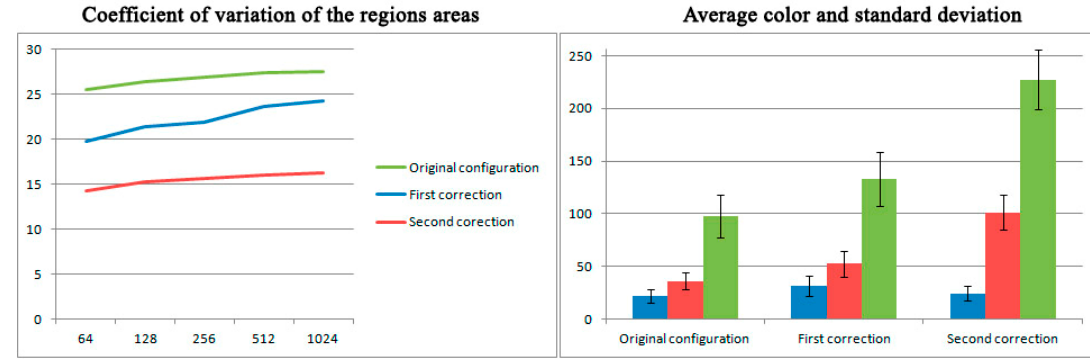
Figure 10. Results of the tests in the three iterations of the workflow.